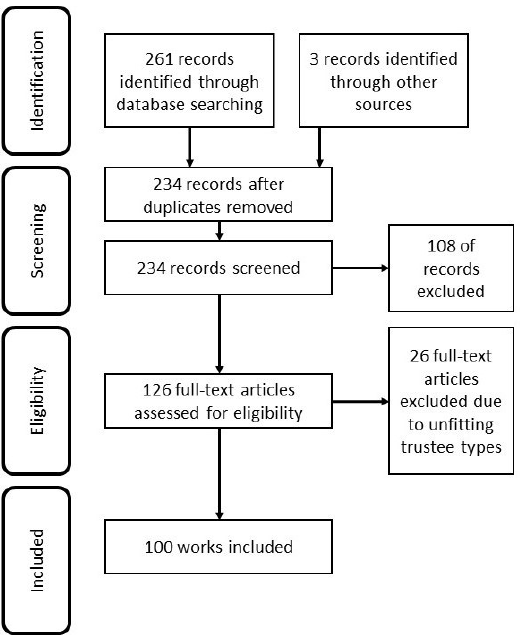
Figure 1. PRISMA flow diagram.